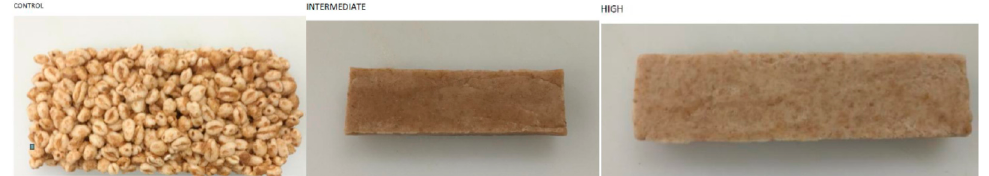
Figure 1. Cold pressed bars: control ( left ), medium-fiber ( middle ) and high-fiber ( right ).